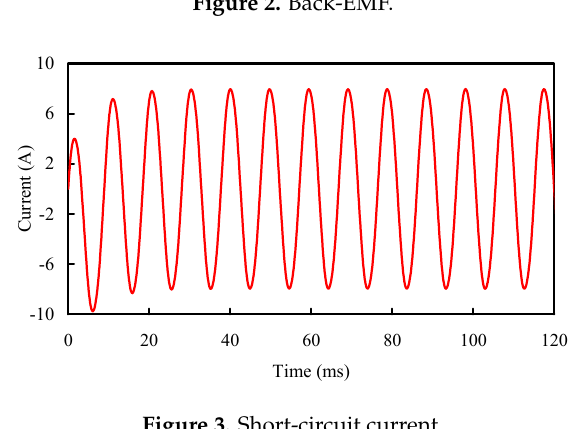
Figure 2. Back ‐ EMF. Figure 2. Back-EMF.